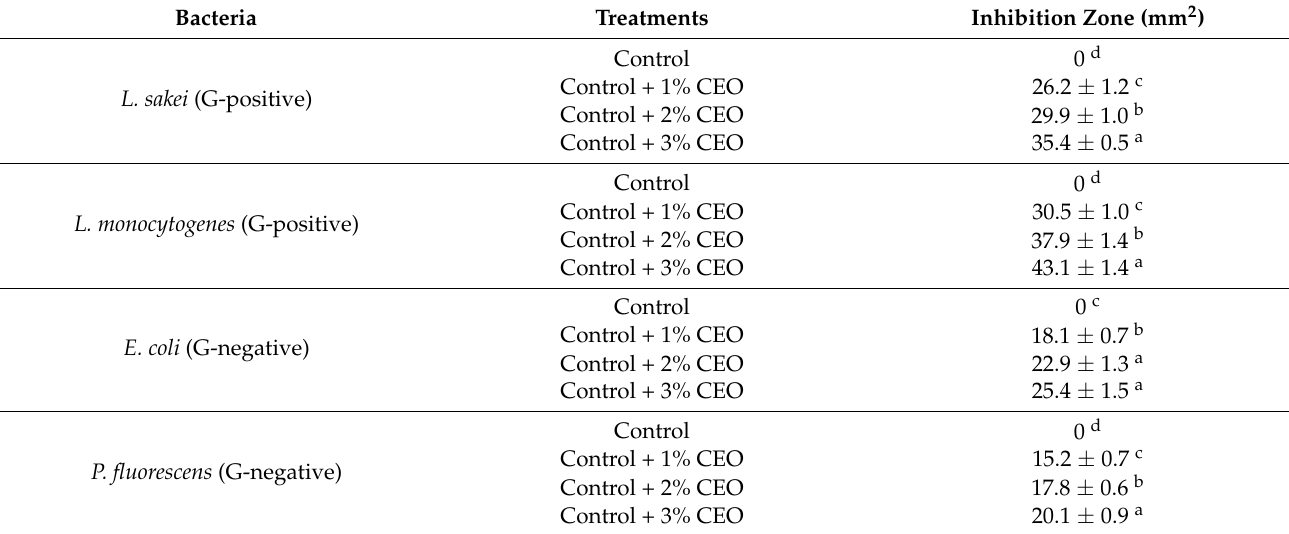
Table 4. Antibacterial activity of CEO-loaded PBS-PVA blend films against various G-positive and G-negative bacteria. Bacteria